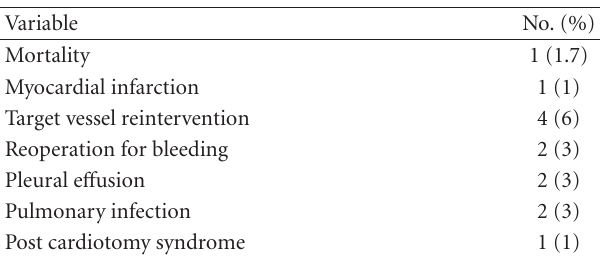
Table 4: Adverse